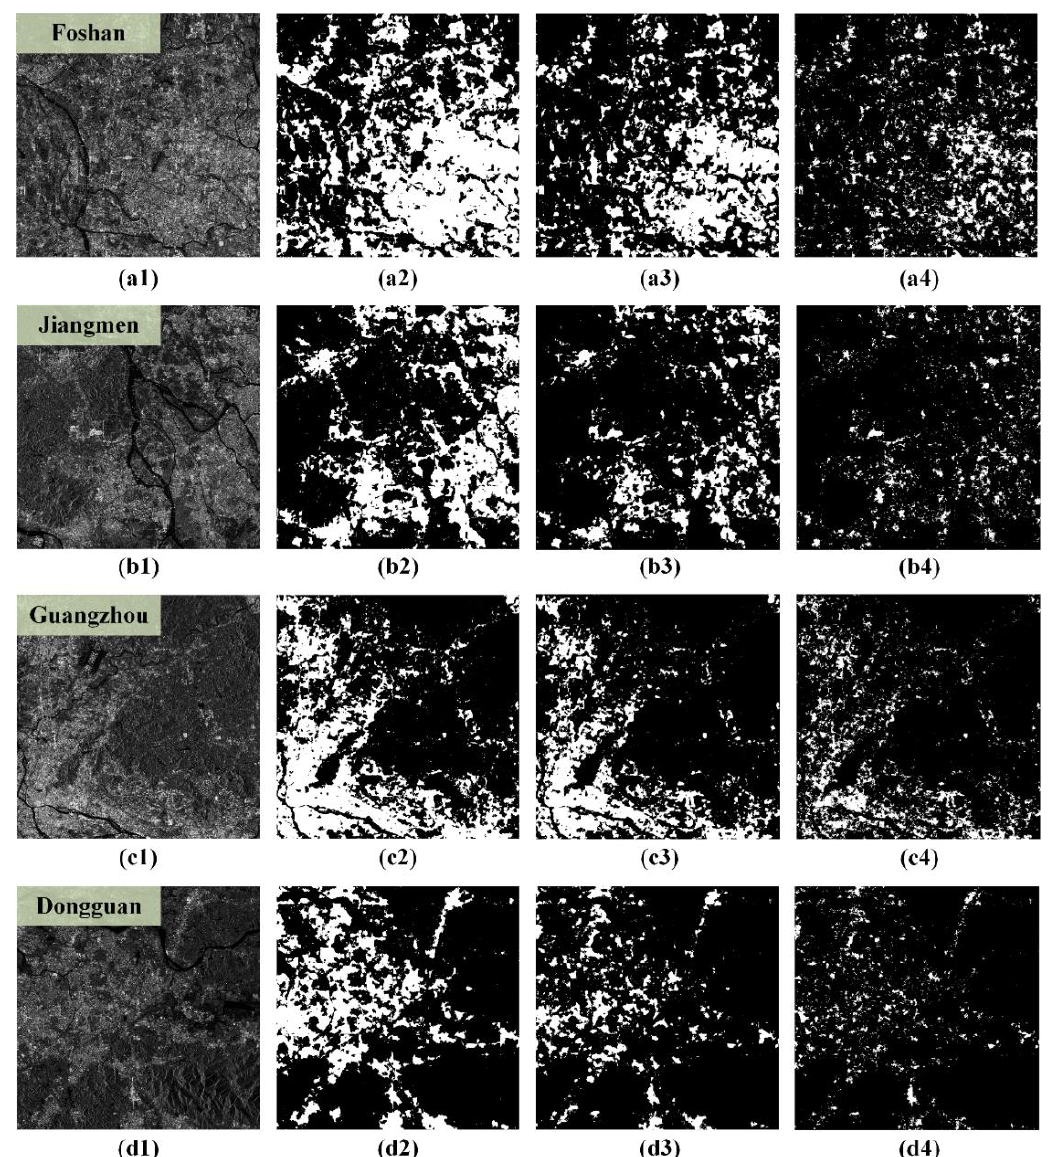
Figure 13. BAs extraction results with different components of our method. ( a1 – d1 ) SAR images of the four cities. ( a2 – f2 ), ( a3 – f3 ), ( a4 – f4 ) Results of our original method, our method without the speckle divergence feature, and our method without the spatial statistical features.